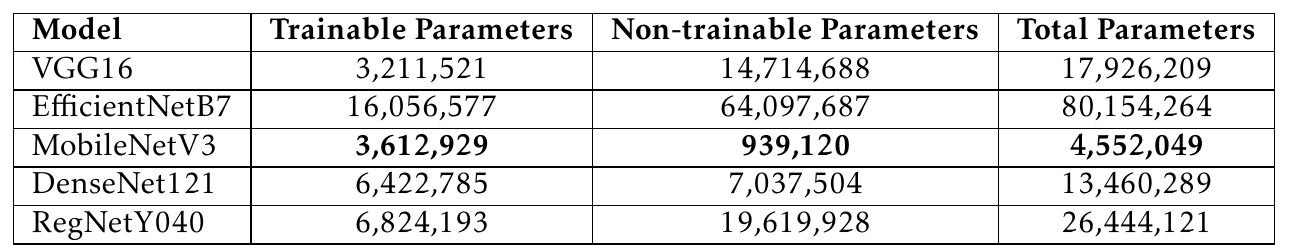
Table 5. Numbers of parameters for each model